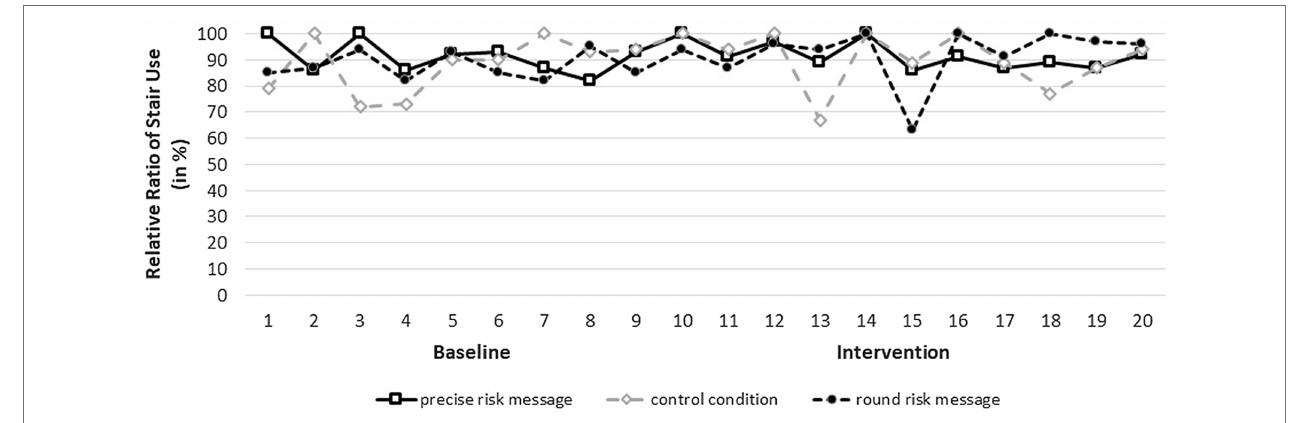
FIGURE 2 | Illustration of stair use rates over baseline period and intervention